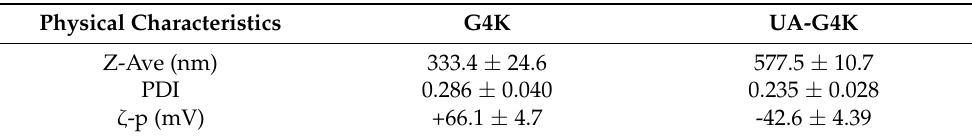
Table 4. Results obtained from DLS analyses on G4K and UA-G4K: particle size (Z-ave, nm), polydispersity index (PDI) and zeta potential ( ζ